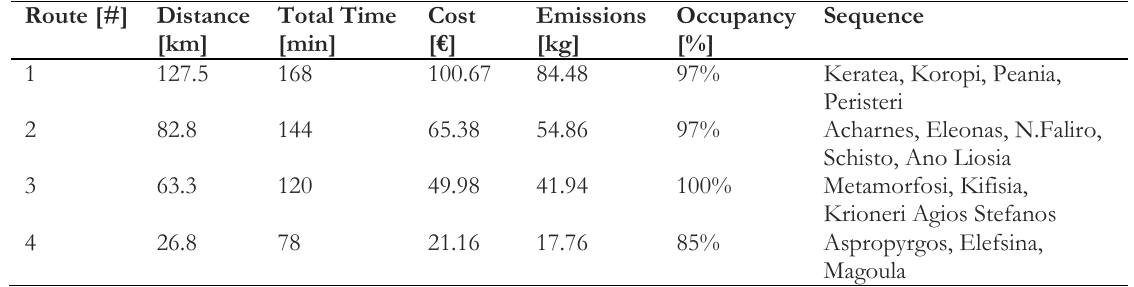
Table 6. Vehicle routing – SS1 results.